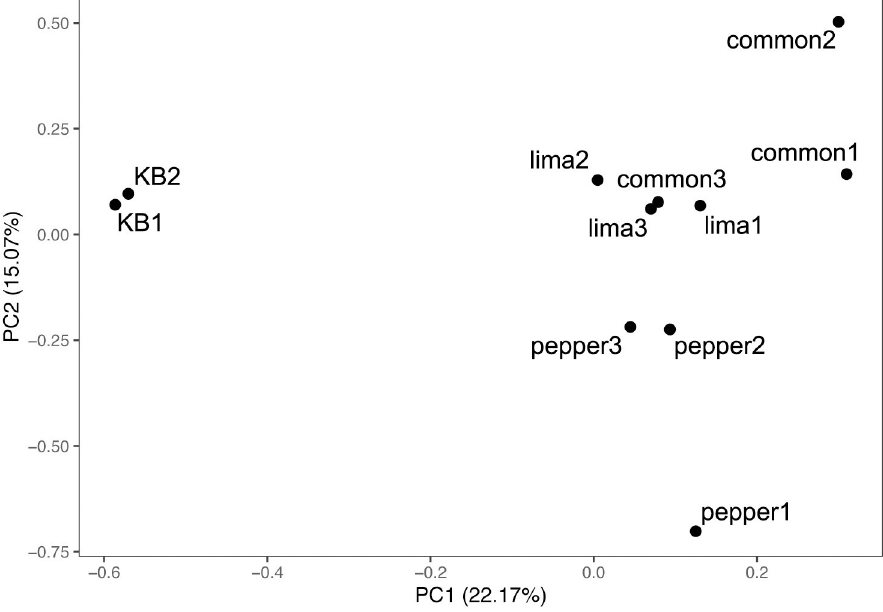
Fig 1. Principle component analysis of Pseudomonas syringae B728a grown in King’s B (KB), common bean (“common”), lima bean (“lima”), or pepper. Plot generated using gene fitness values calculated for 4,296 genes. Replicate experiments are noted as the numbers 1 to